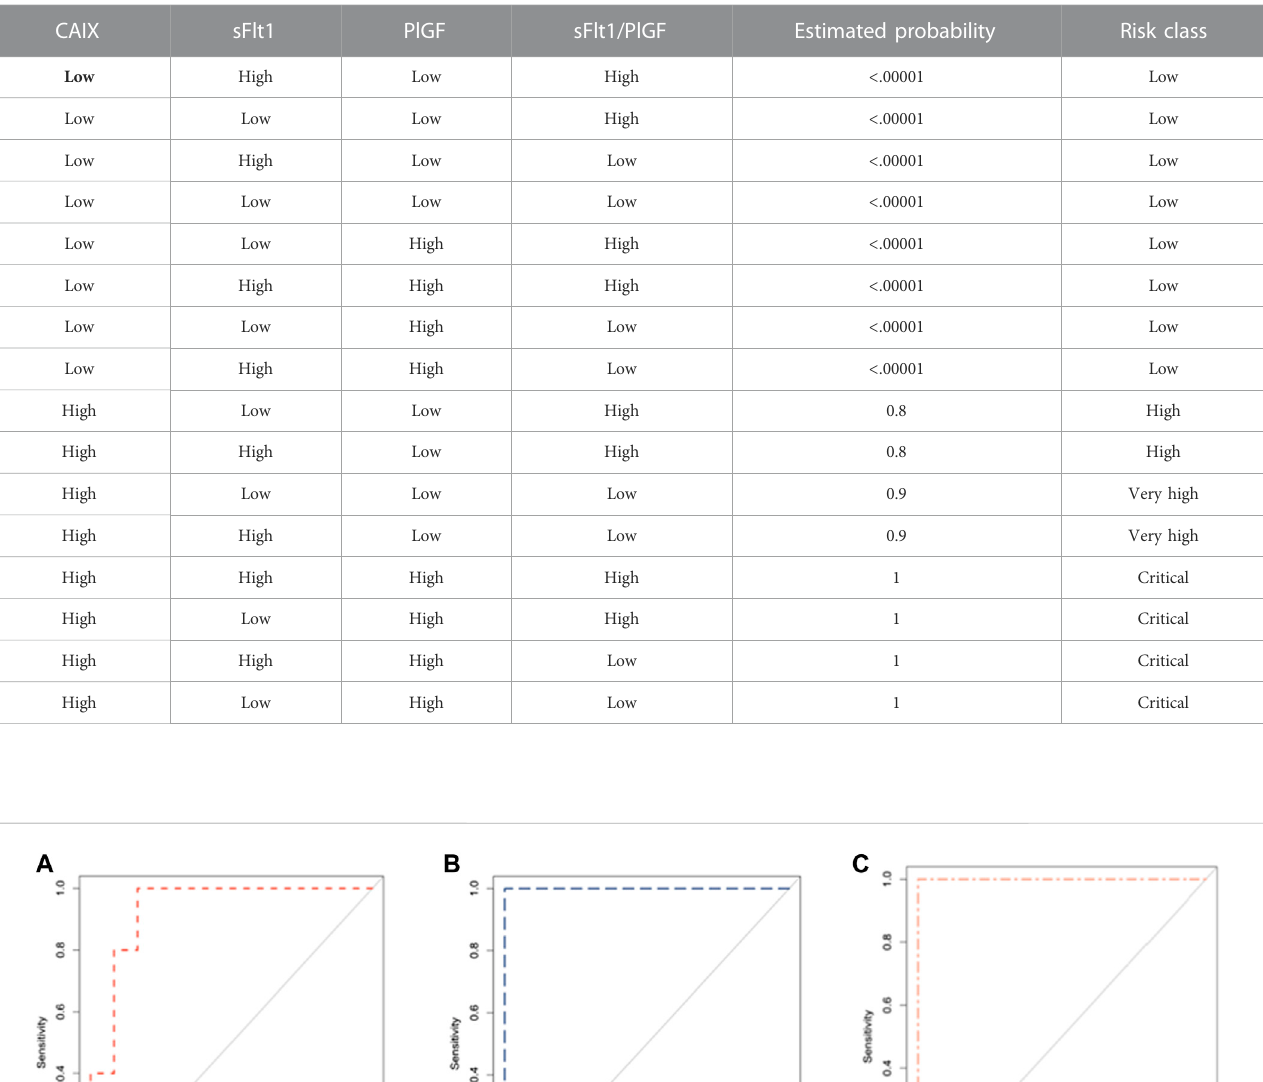
TABLE 4 Fitted probability of PE as a function of the expression of the different biomarkers. “ Low ” and “ high ” values are referred to the relative optimal cut-offs reported in Table 3. Given the sample size, the values should be considered carefully.